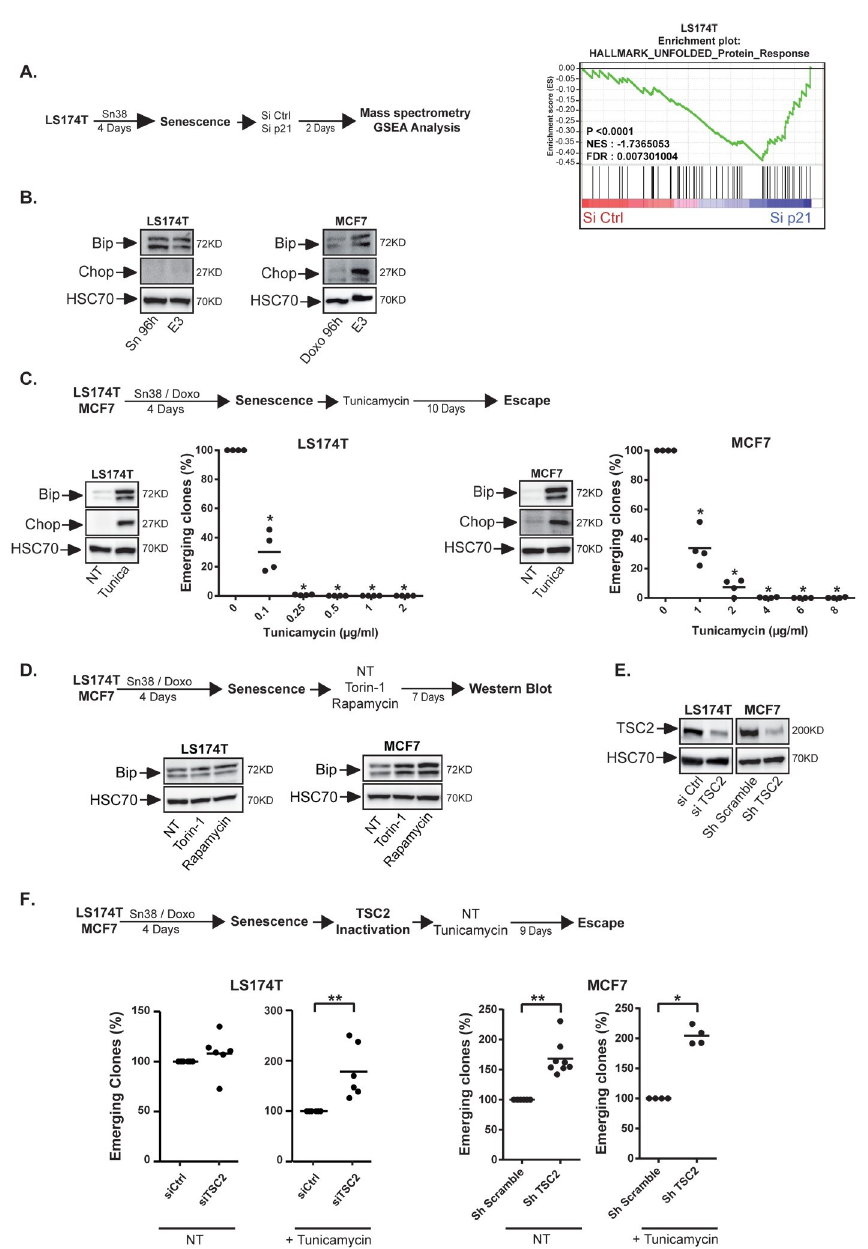
Fig 2. mTOR allows senescence escape in the presence of an ER stress. A. Senescent cells were transfected with a control siRNA or a siRNA directed against p21. Cell extracts were analyzed by SWATH quantitative proteomics and GSEA analysis 2 days after p21 depletion (n = 3). B. Analysis of the expression of the UPR markers in LS174T and MCF7 senescent cells after 3 days of emergence (noted E3 on the figure, n = 3). C. Senescent MCF7 and LS174T cells were treated with increasing concentrations of tunicamycin as indicated and the number of emerging clones was evaluated 10 days later (n = 4, Kolmogorov-Smirnov test, � = p < 0.05). UPR induction was validated by Western blot 24 hr after the treatment of senescent cells with the lowest concentration of tunicamycin (LS174T: 0.1 μ g/ml, n = 2; MCF7:1 μ g/ml, n = 2). D. After senescence induction, cells were stimulated with 10% FBS in the presence or absence of mTOR inhibitors. Cell extracts were recovered 7 days later and the expression of Bip was analyzed by western blot (n = 3). E, F. Following senescence induction, cells were transduced with a control shRNA or a shRNA directed against TSC2 (MCF7) or with a control siRNA or a siRNA directed against TSC2 (LS174T cells). TSC2 inhibition was validated by western blot 2 days after transduction (E. LS174T n = 2, MCF7 n = 1). F: Cells were then washed and treated or not with tunicamycin (LS174T: 0.1 μ g/ml, MCF7 1 μ g/ml) and emergence was then evaluated as above (n = 4 to 8, Kolmogorov-Smirnov test, � = p < 0.05 �� = p < 0.01).